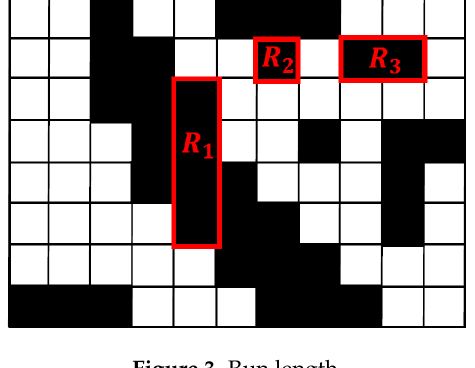
Figure 3. Run length.